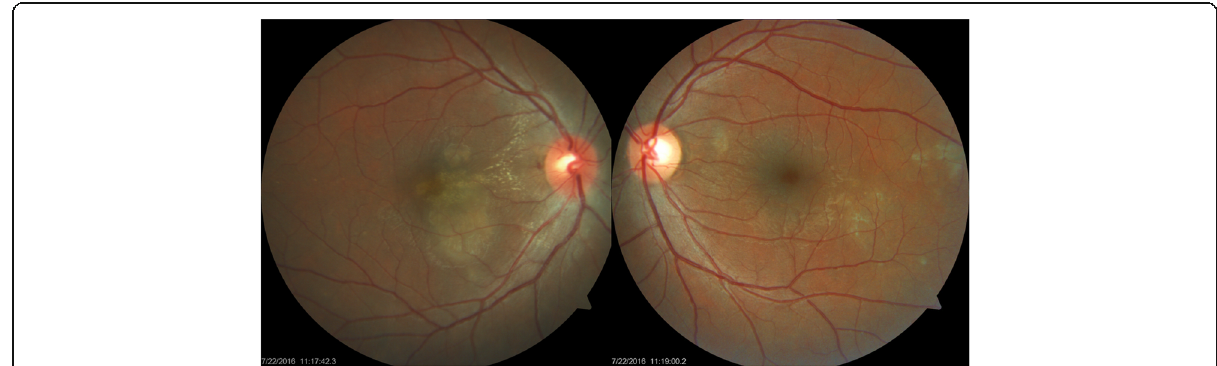
Fig. 1 Fundus photographs of both the eyes at presentation. In the right eye , mild disc hyperaemia as compared to the left eye is noted. There is presence of punctuate retinal hemorrhage at temporal disc margin with hard exudates along papillomacular bundle. Multifocal yellow deep choroidal lesions are noted nasal to fovea. The left eye fundus picture shows normal disc with hard exudates superonasal and inferotemporal